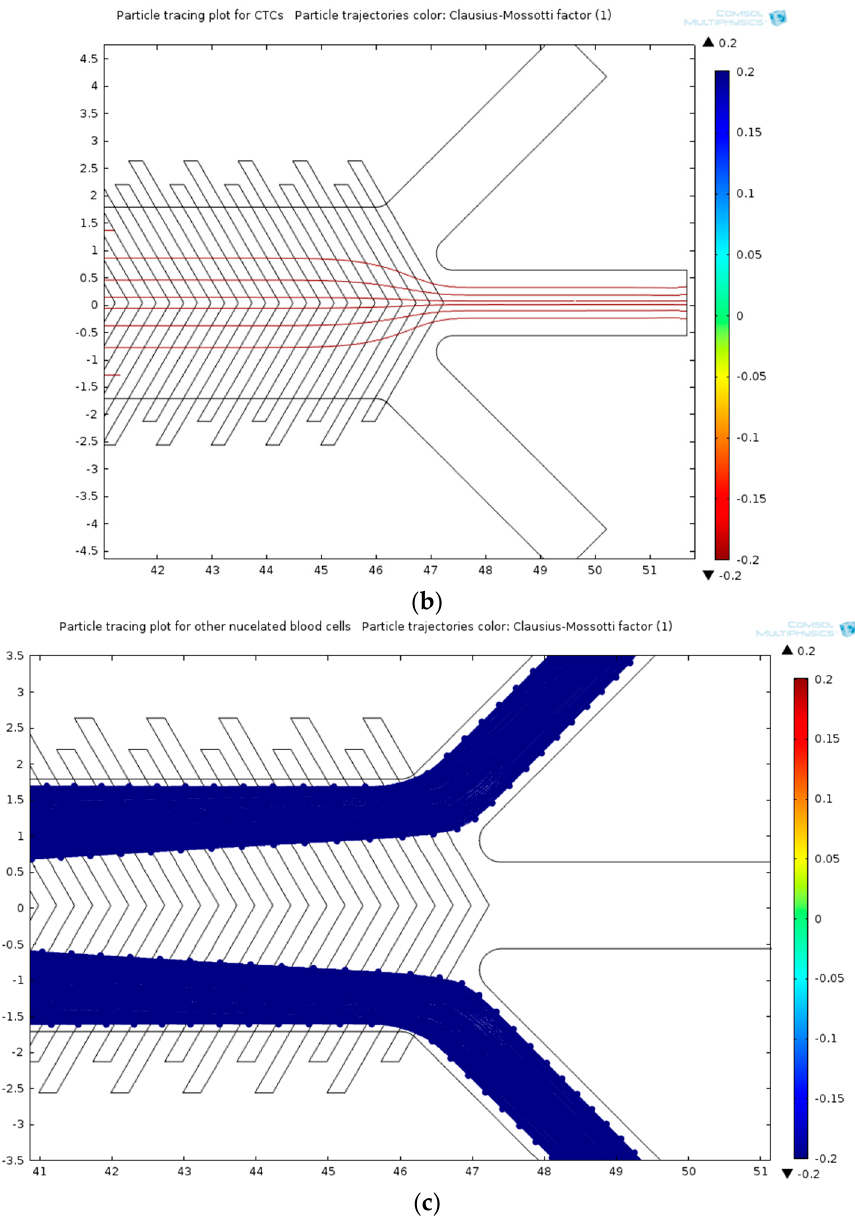
Figure 15. ( a ) Schematic of the microchannel architecture of integrated MAP-DEP microsystem. When cells isolated from the MAP stage are directed toward the DEP stage, the trajectories of nucleated cells such as WBC (and platelet) and CTCs are displayed in ( b , c ), respectively. The spectrum bar indicates the Clausius-Mossotti factor of the cells.